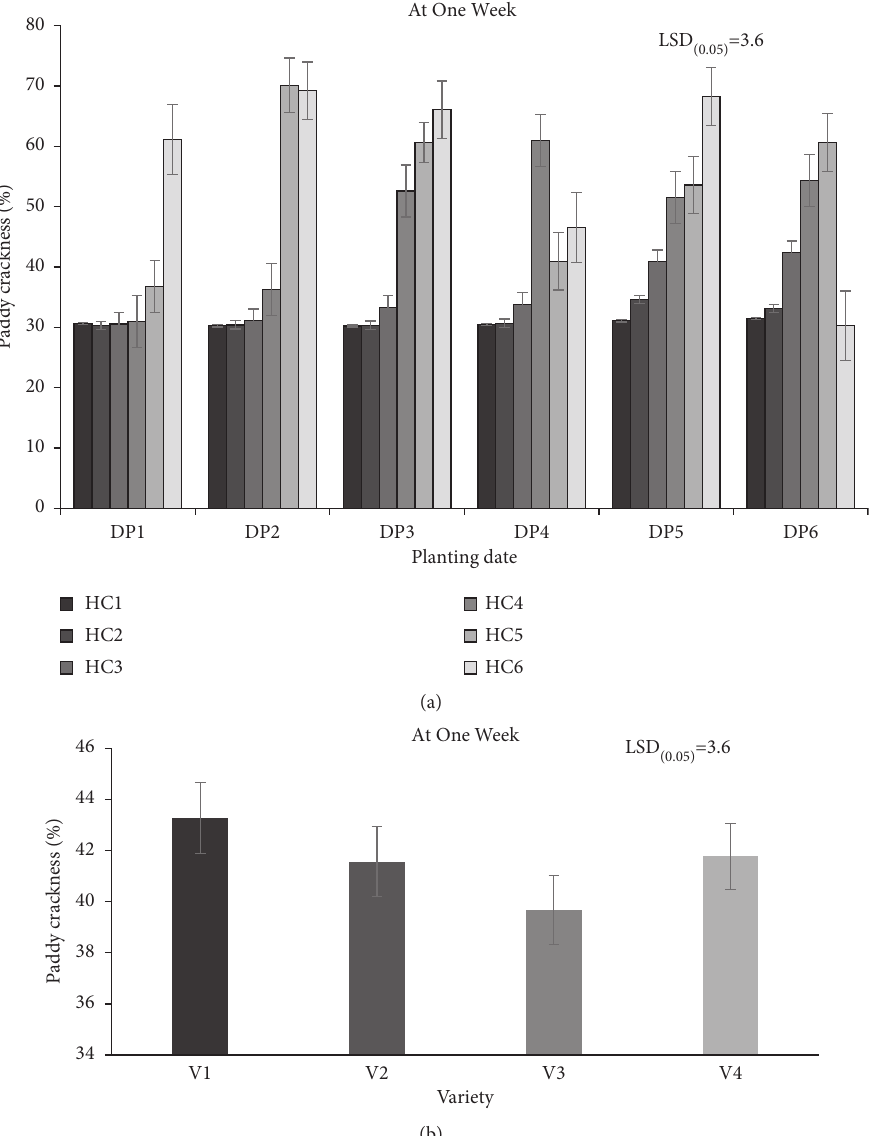
Figure 3: (a) Effect of planting date and harvest cycle on paddy crackness at one week of storage in the Northern Savanna Agroecological Zone of Ghana. Bars represent the SEM. DP1 � first planting, DP2 � second planting, DP3 � third planting, DP4 � fourth planting, DP5 � fifth planting, DP6 � sixth planting, V1 � Agra, V2 � Gbewaa, V3 � Exbaika, V4 � Perfume Irrigated, HC1 � first harvest, HC2 � second harvest, HC3 � third harvest, HC4 � fourth harvest, HC5 � fifth harvest, and HC6 � sixth harvest. (b) Effect of perfumed rice varieties on paddy crackness at one week of storage under rain-fed production systems in the Northern Savanna Agroecological Zone of